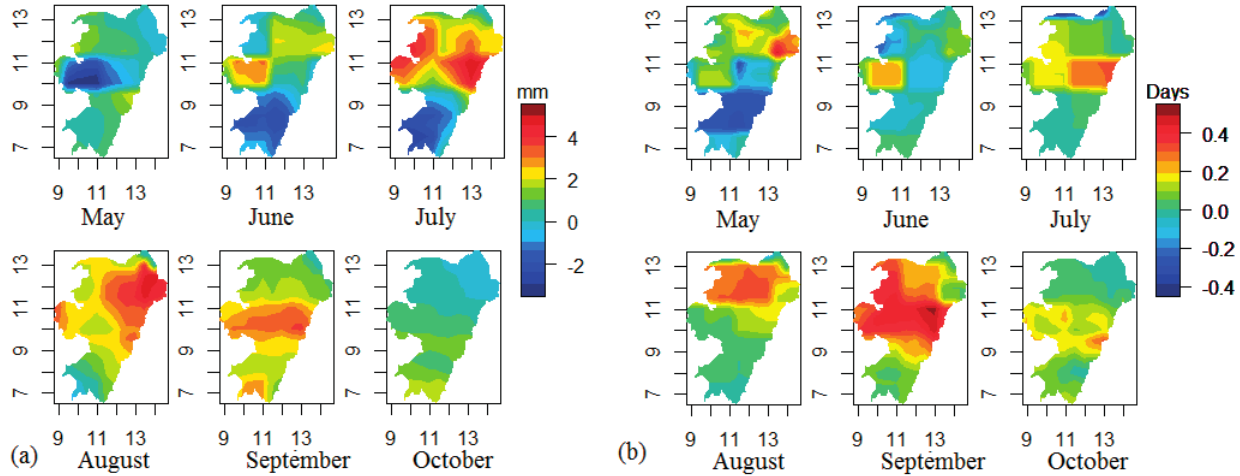
Figure 2. Regression slopes over a 27-year period (1980–2006) of ( a ) the monthly rainfall amounts in mm·yr − 1 and ( b ) the frequency represented by number of rain days in a month in days·yr − 1 from May–October. The axes show the latitude and longitude coordinates in